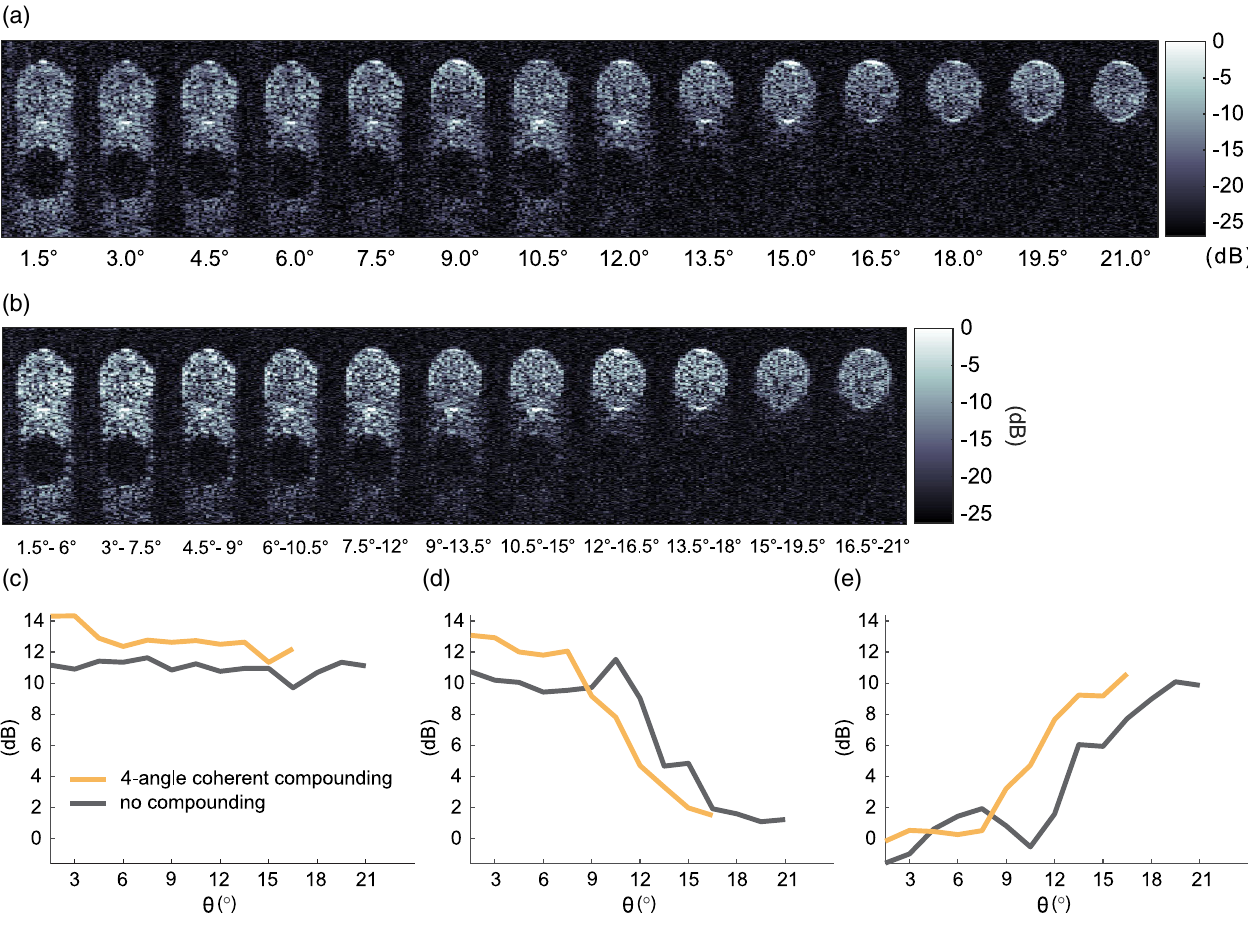
FIG. 10. Comparison of coherently compounded and single-acquisition xAM images of the hGV inclusion in the tissue- mimicking phantom reported in Fig. 5(a). (a) A set of xAM images from the experiment depicted in Fig. 5. (b) The same images with coherent compounding applied to successive sets of four acquisitions. (c) Contrast-to-tissue ratio of single-acquisition xAM compared with coherently compounded data as a function of angle. (d) Artifact-to-tissue ratio. (e) Contrast-to-artifact ratio. Here, n ¼ 6 . Error bars are not shown for ease of Fig. 9. The third transmission event of the xAM sequence [Fig. 2(c)] corresponds to a finite-aperture forward- propagating X-wave solution of the homogeneous and isotropic wave equation with the form f ð x; z − c X t Þ [28], where f represents a scalar function (e.g., the acoustic